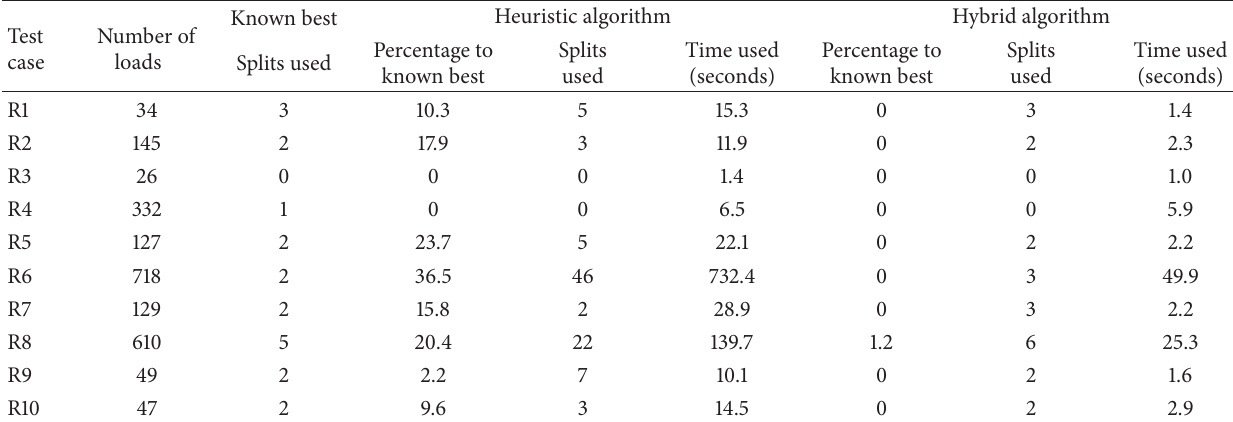
Table 3: Result of test cases with unlimited splits allowed.